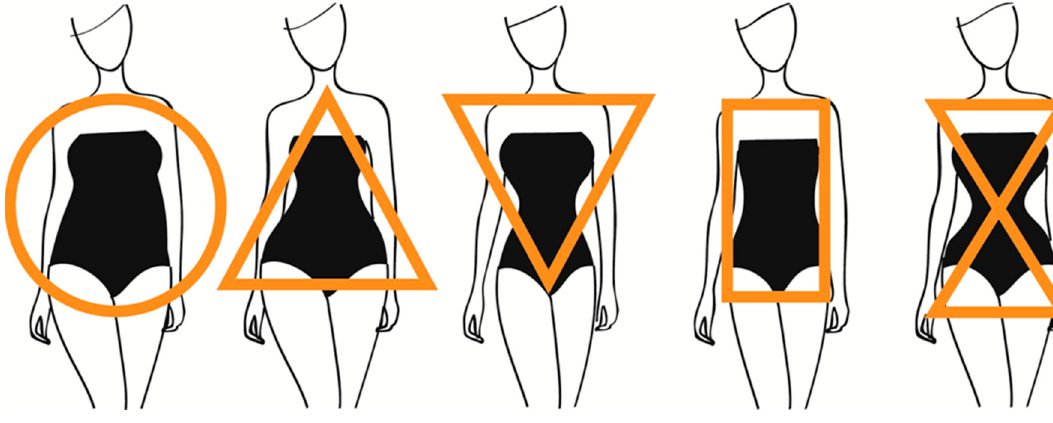
Figure A3. Current Body Shape.